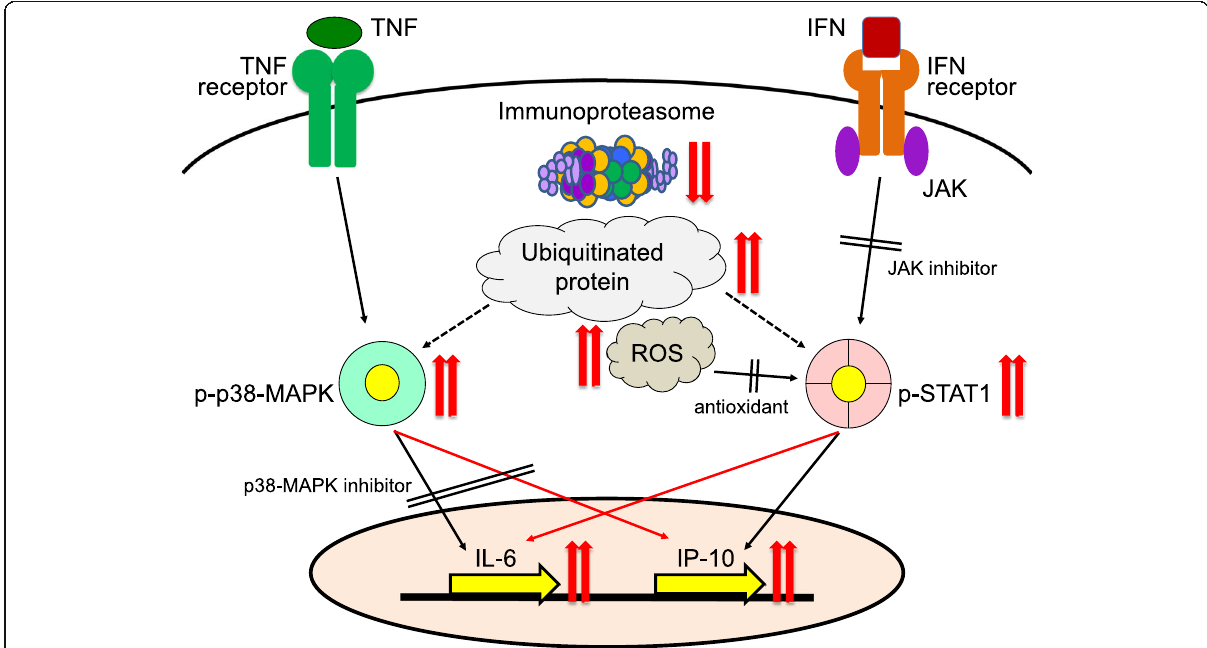
Fig. 4 Scheme of the autoinflammatory pathomechanism in NNS. In NNS-type-mutated PSC-MLs, the ROS productions as well as the accumulation of ubiquitinated proteins are constitutively induced by the iP dysfunction. The STAT1 phosphorylation contributed by ROS, accompanied by the p38-MAPK phosphorylation, provides the “ priming ” inflammatory signal. After IFN- γ plus TNF- α -stimulation, any of a pan-JAK inhibitor, a p38-MAPK inhibitor, and antioxidants significantly reduced both IL-6 and IP-10 secretion, suggesting a pathological crosstalk between the IFN-JAK-STAT-IP-10 pathway and the TNF- α -p38-MAPK-IL-6